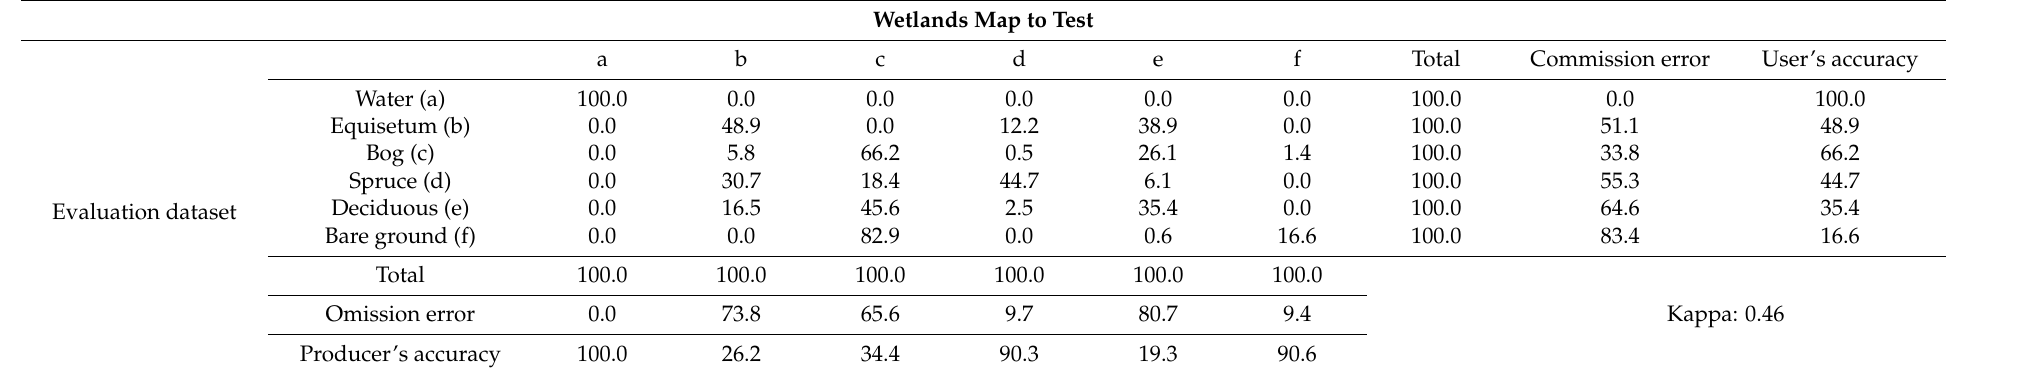
Table A1. Confusion matrix for area A hybrid classification. Results in %.